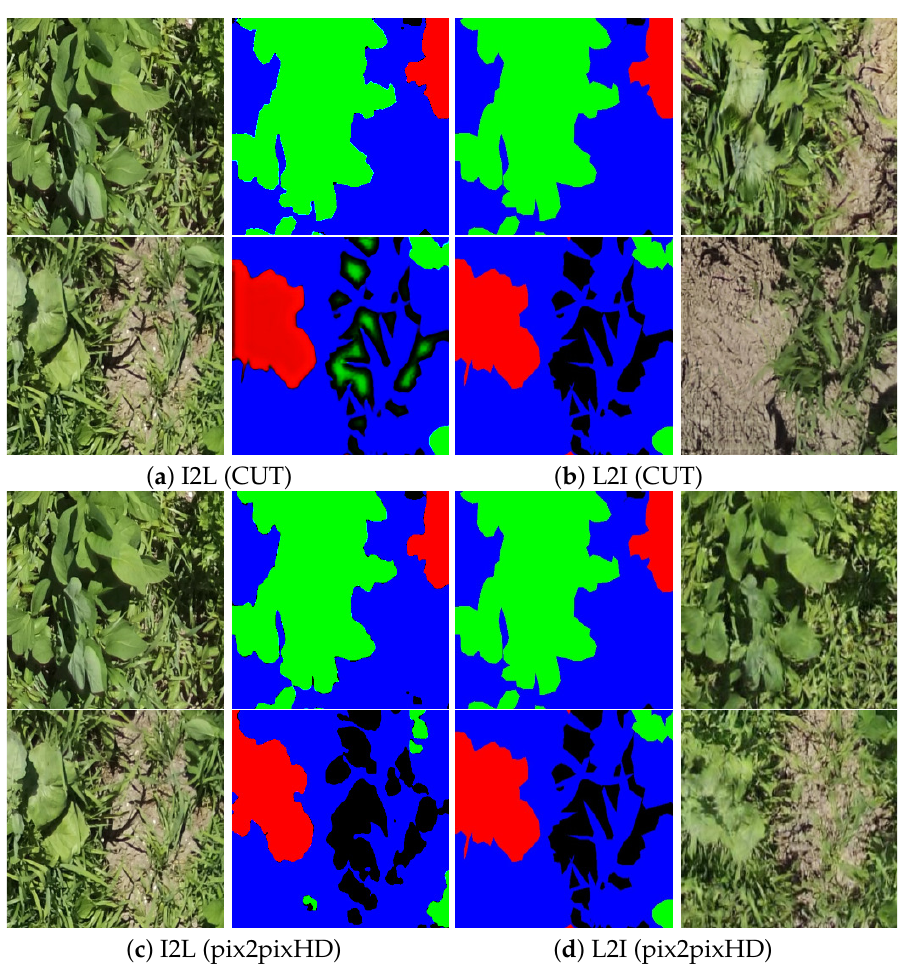
Figure 14. I2L and L2I style transfer results for the respective GANs in